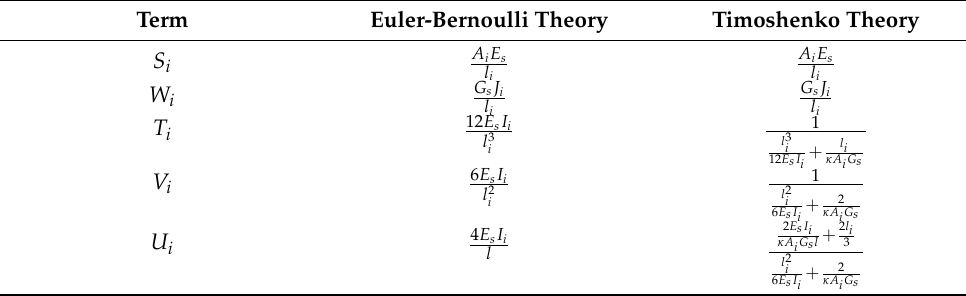
Table 1. Parameters defined for summarizing the relationships for Euler–Bernoulli and Timoshenko beam